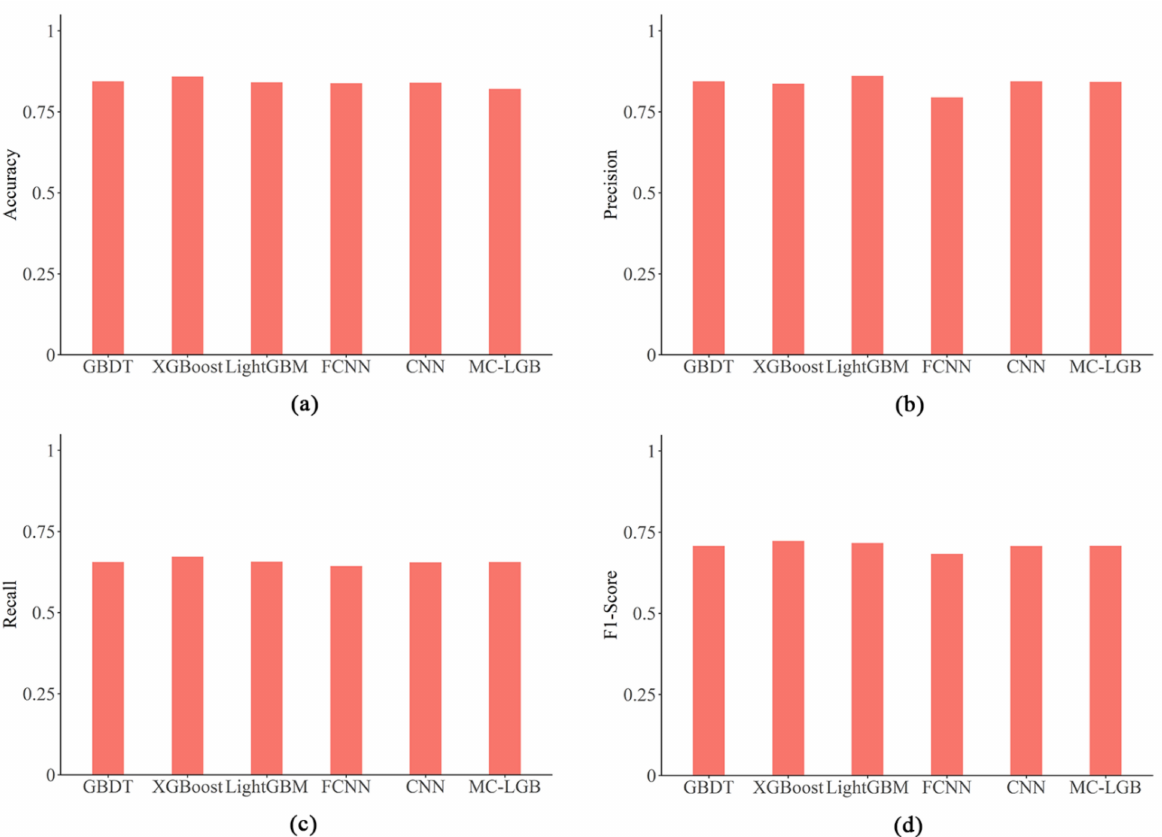
Figure 2. ( a ) Accuracy of classifiers on the KPG dataset; ( b ) precision of classifiers on the KPG dataset; ( c ) recall of classifiers on the KPG dataset; and ( d ) F1-Score of classifiers on the KPG